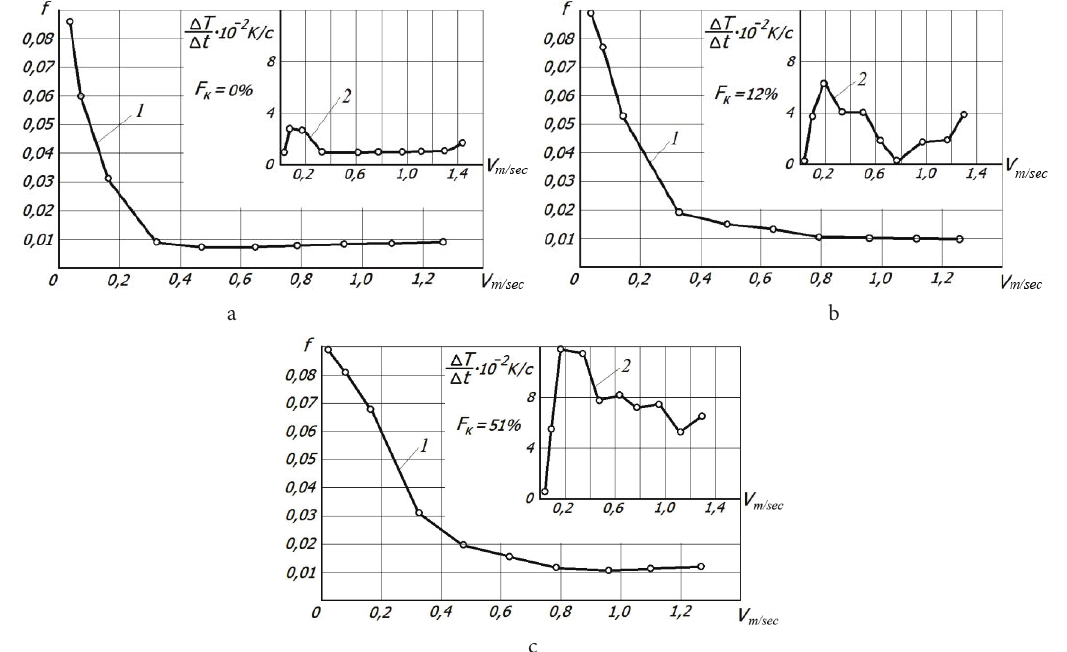
Figure 9. The dependence of friction coefficient f ( 1 ) and rate of temperature change T / Δ t ( 2 ) sersus slip velocity V at relative area of microgrooves F к : а – F к = 0 %; б – F к = 12%; в – F к =